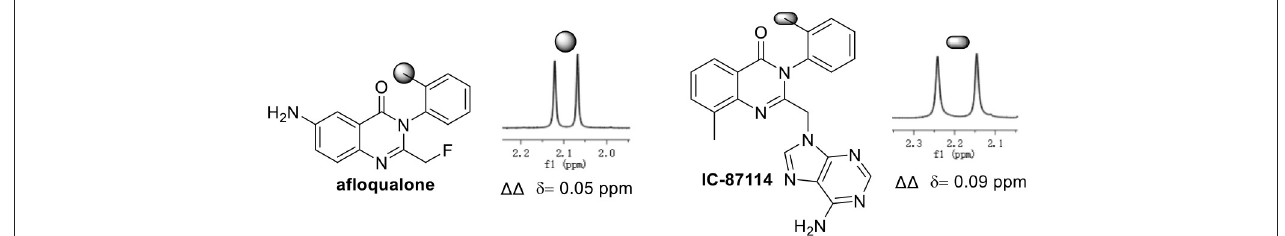
FIGURE 2 | afloqualone and IC-87114 were discriminated under standard conditions.